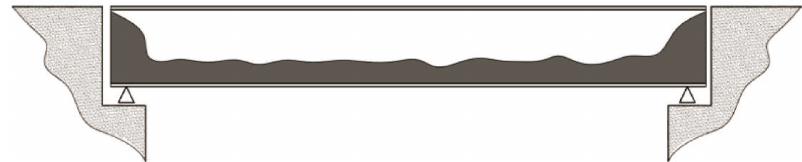
Figure 12. Typical location of corrosion on steel girder bridge